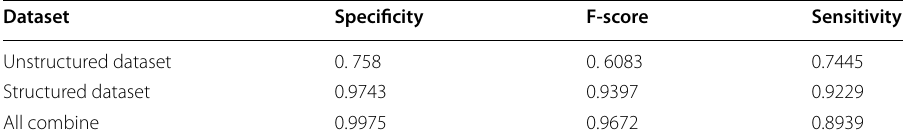
Table 5 Specificity, precision and recall results